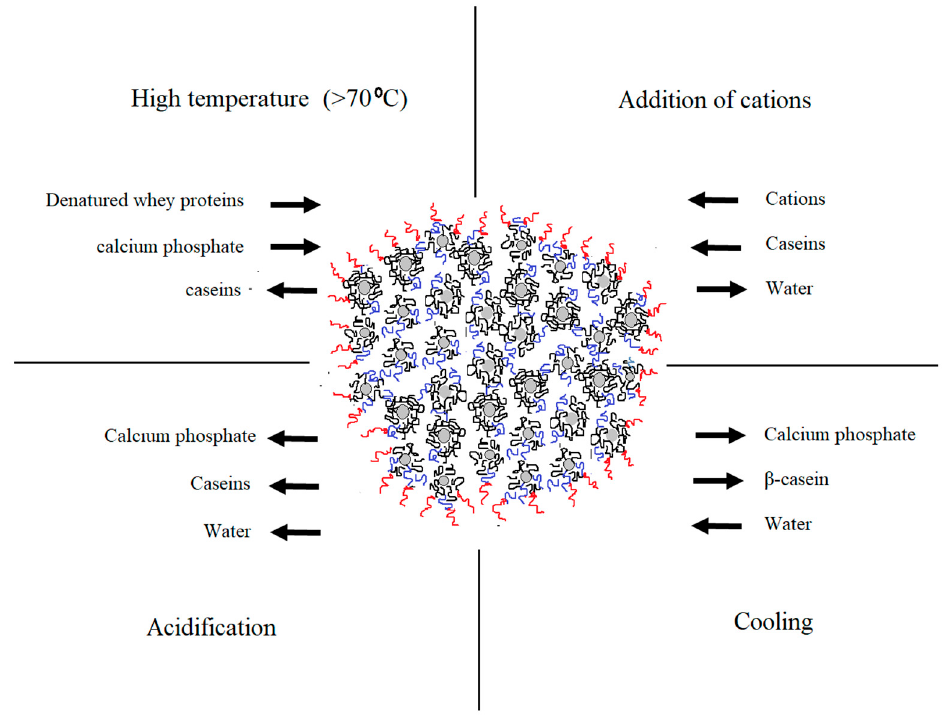
Figure 1. Changes in the native equilibrium of casein micelle in particular physio-chemical conditions during dairy processing (adapted from Gaucheron [11]).